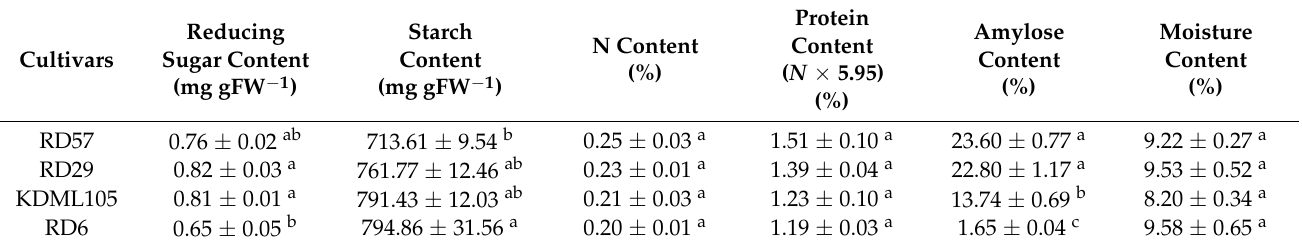
Table 1. The amounts of seed carbohydrates and starch chemical compositions of four Thai commer- cial rice cultivars differing in starch pasting